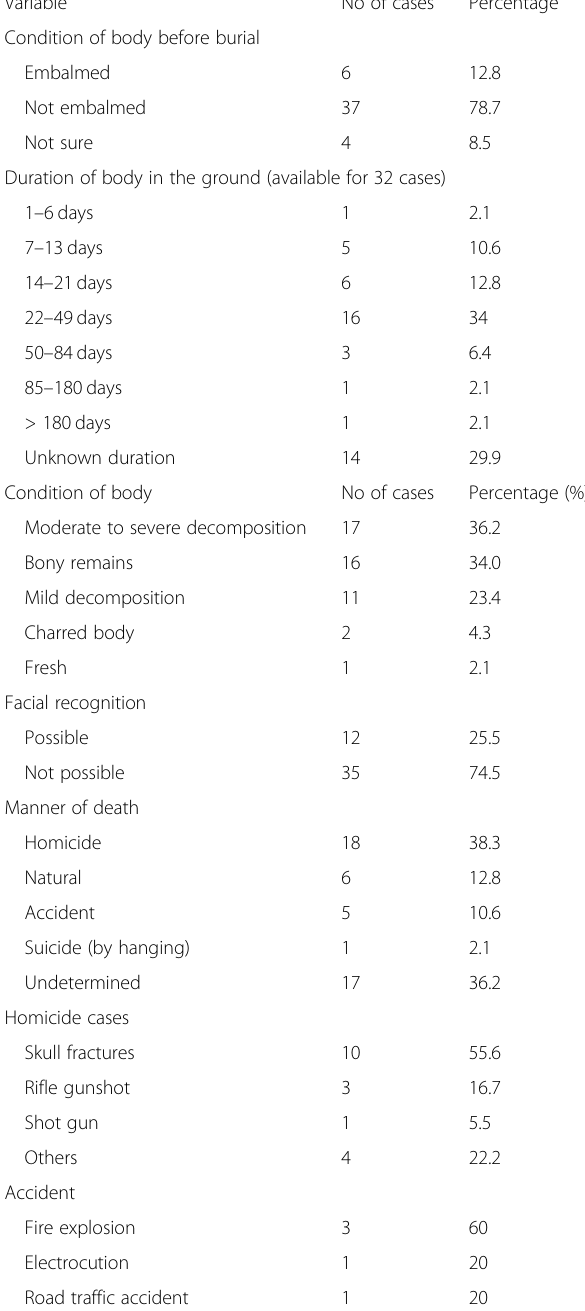
Table 3 Duration of body underground, condition of body